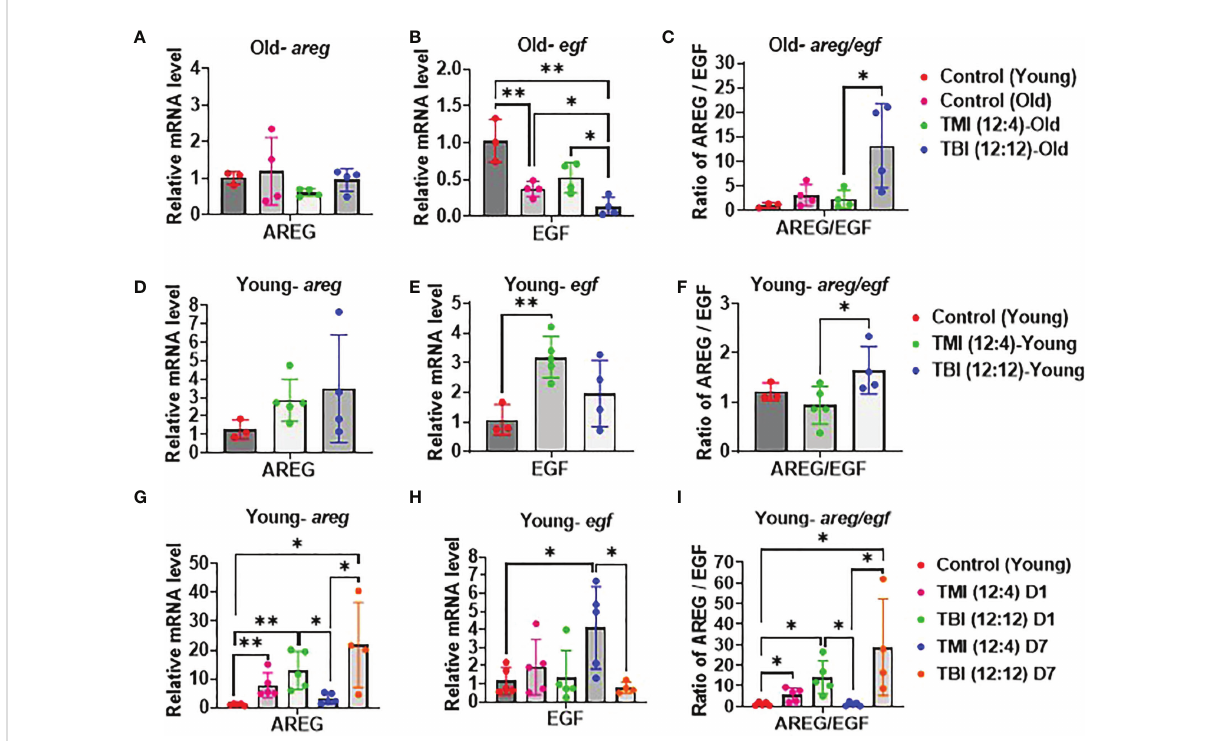
FIGURE 6 Damage and repair in TMI, TBI, and untreated control in young mice. (A – C) Relative mRNA level of AREG/EGF ratio, AREG and EGF expression. qPCR analysis in old mice at 12 weeks after Rx/BMT. (D – F) Relative mRNA level of AREG/EGF ratio, AREG and EGF expression. qPCR analysis in young mice at 12 weeks after Rx/BMT. (G – I) Relative mRNA level of AREG/EGF ratio, AREG and EGF expression in young mice at day 1 and day 7 after irradiation without BMT. (* <0.05, **< 0.01, unpaired t